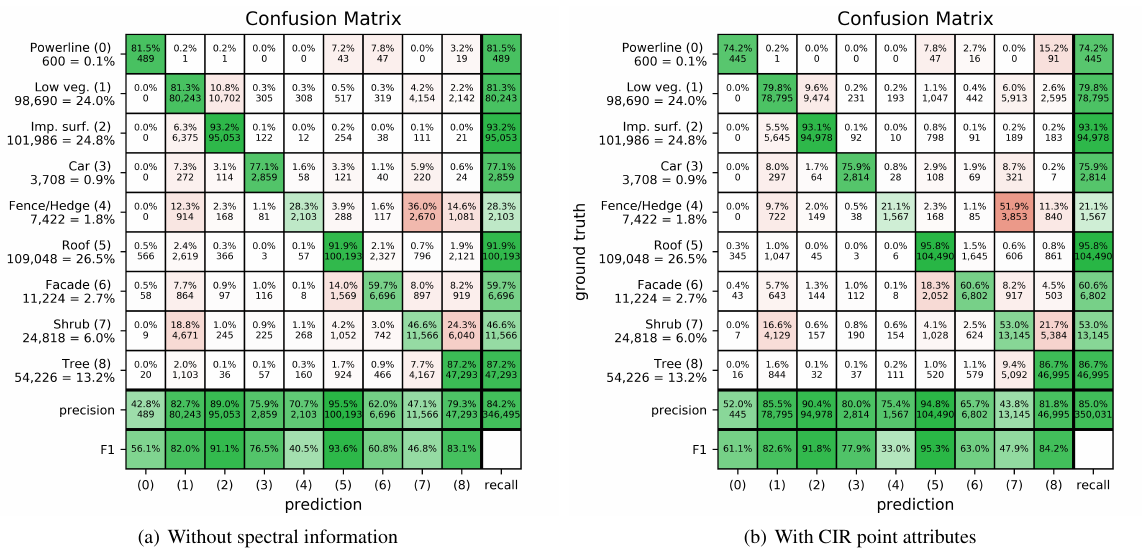
Figure 5. Detailed V3D test set segmentation results from two ensembles: (a) without spectral information (b) with CIR point attributes. Best viewed